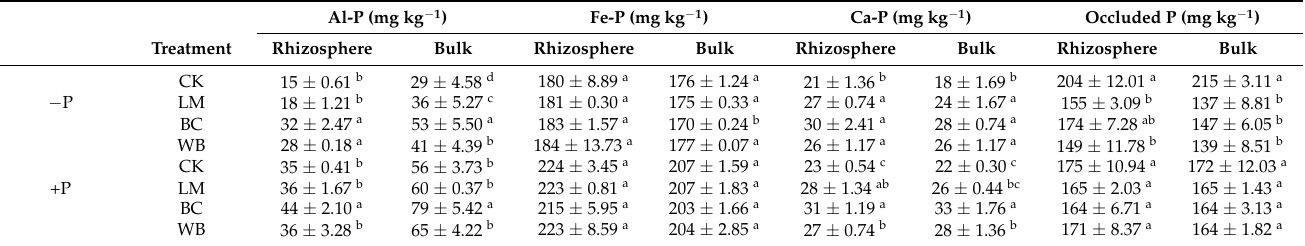
Table 4. Effect of biochar and P supply on phosphorus fractions in the rhizosphere and bulk soil.